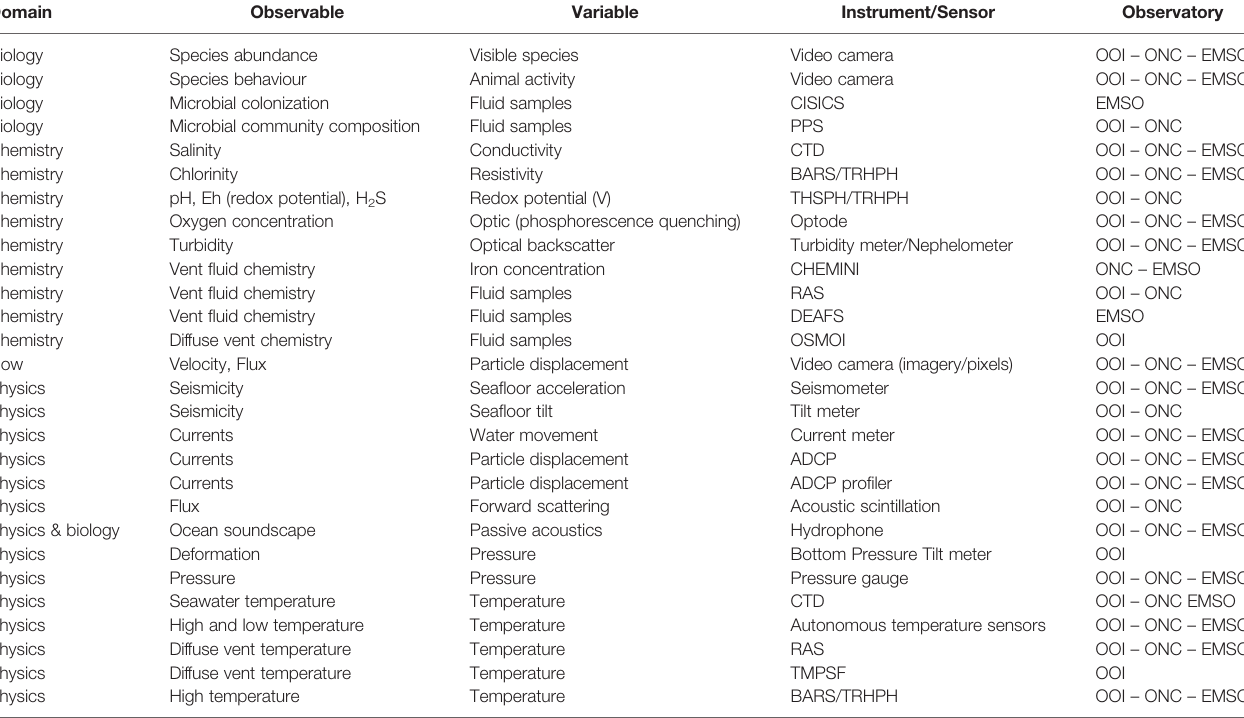
TABLE 2 | List of variables currently measured at the three vent observatory platforms and the corresponding